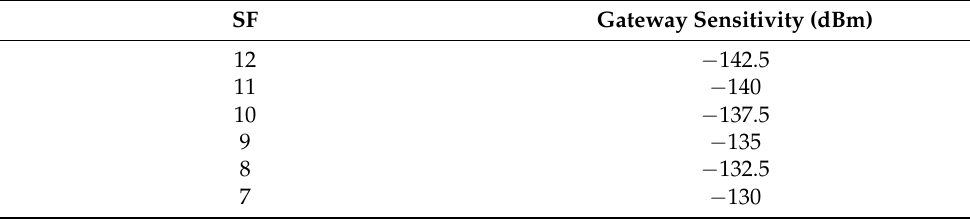
Table 3. Gateway Sensitivity for each SF.